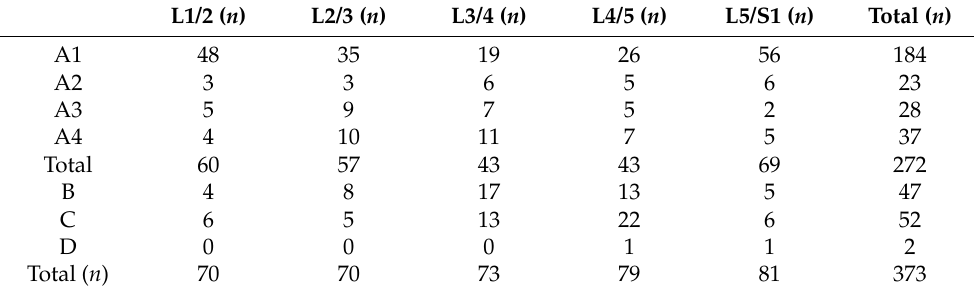
Table 3. Schizas classification (MRI).